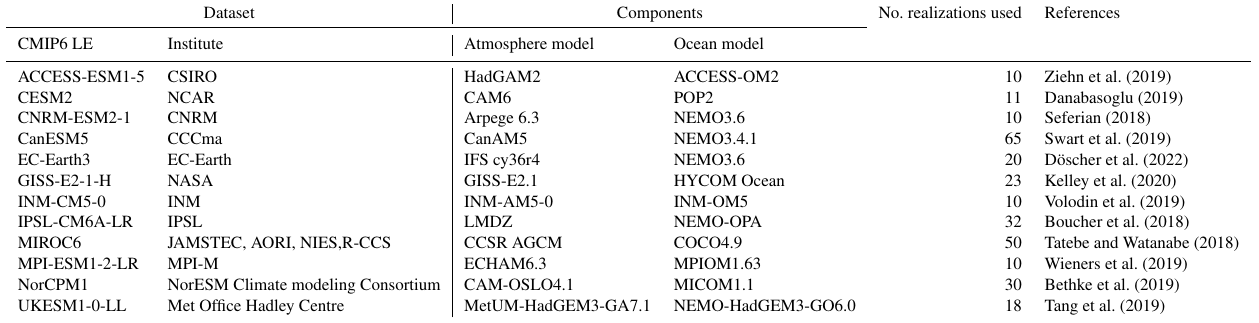
Table 1. CMIP6 large-ensemble historical simulations used in the